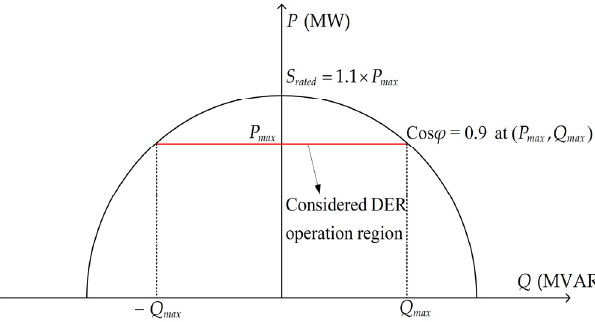
Figure 3. The PQ-diagram of DERs by the proposed method.